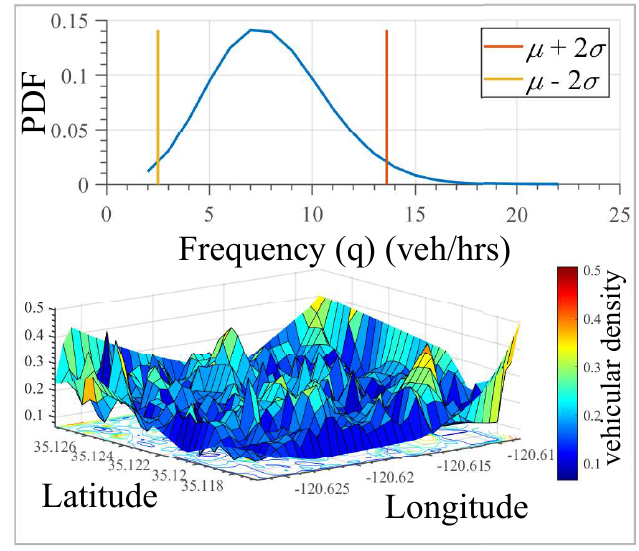
Figure 7. Vehicle density distribution located in geolocated scenario case A.